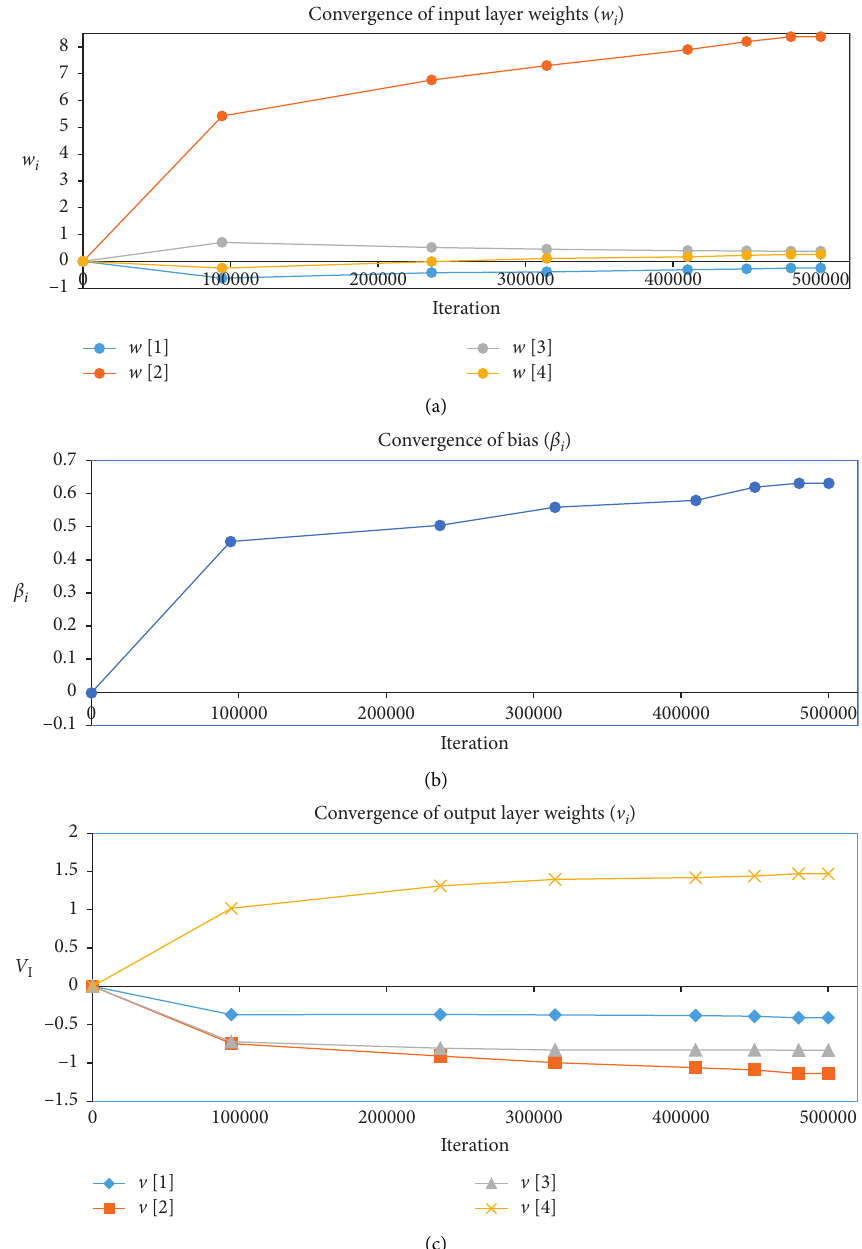
Figure 5: Convergence of the weights of input, bias, and output layers for the training of the NN used to simulate helium burning network. (a) The convergence of input layer weights ( w ). (b) The convergence of bias ( β i ). (c) Convergence of output layer weights ( v i